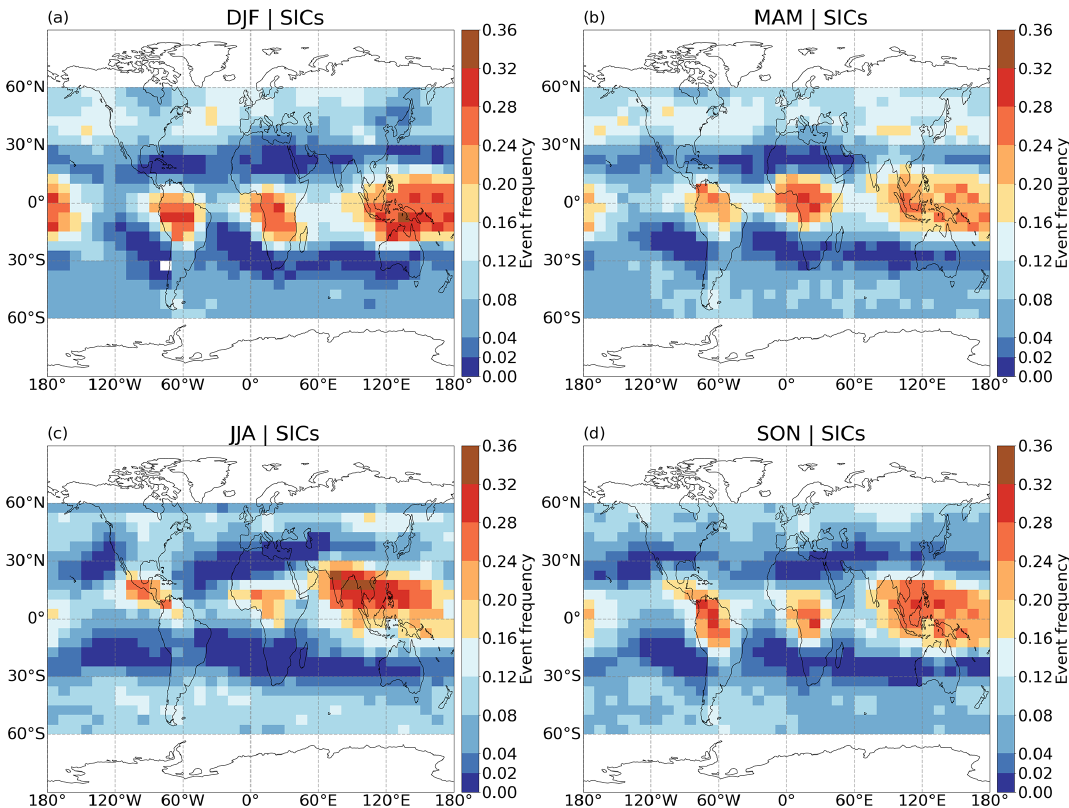
Figure A1. Event frequencies of SICs on a 5 ◦ × 10 ◦ (latitude × longitude) grid box from CALIPSO measurements during